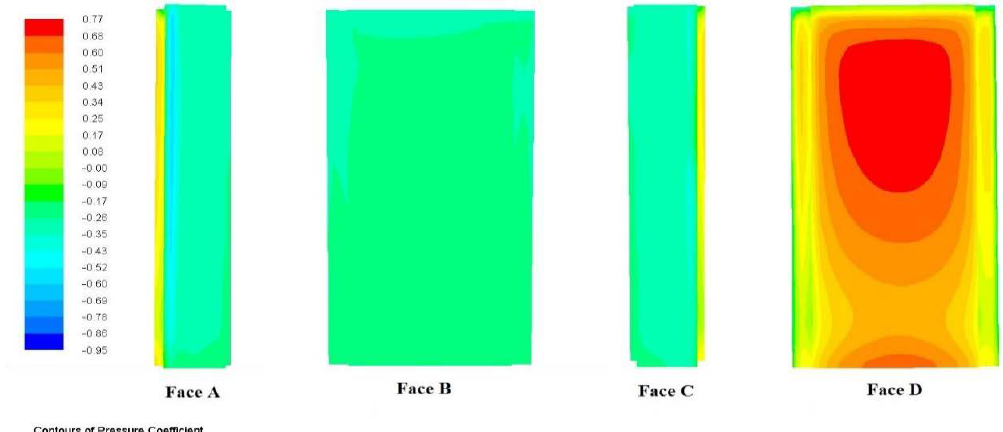
Fig. 5(c). Contours of pressure coefficient at 90° Wind incidence